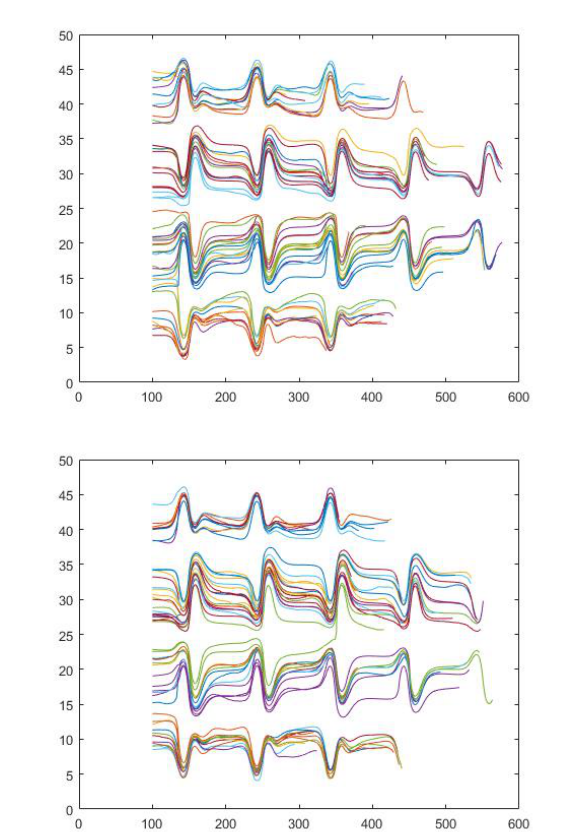
Fig. 18. Geometry C50, two different seedings, the Y- coordinate position in relation to X-coordinate. Values are shifted in the X-direction, to obtain the same starting position for all the cells.